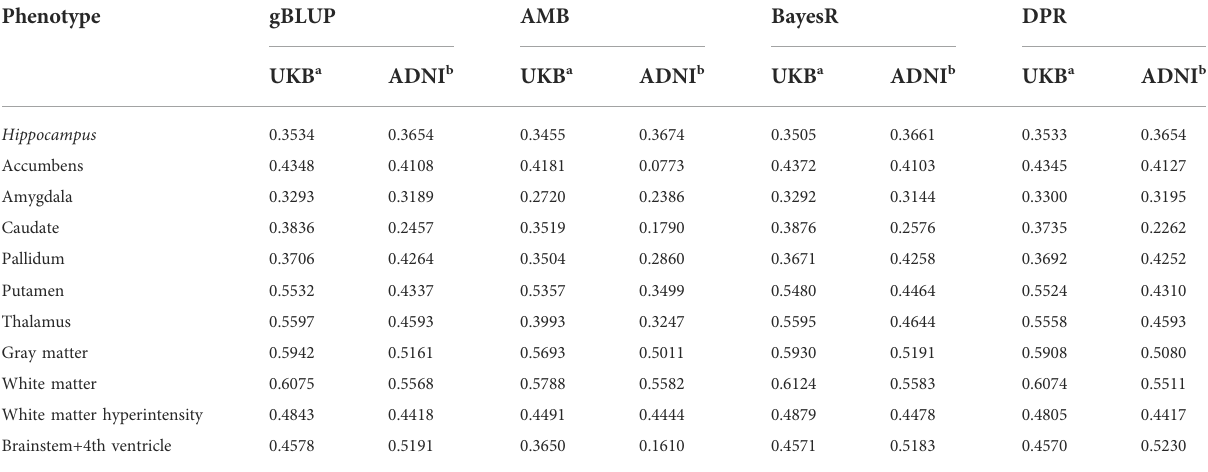
TABLE 4 The Pearson correlation for cross-validation and external validation for eleven brain imaging traits that are predicted using genetic variants and demographic variables (age, sex and